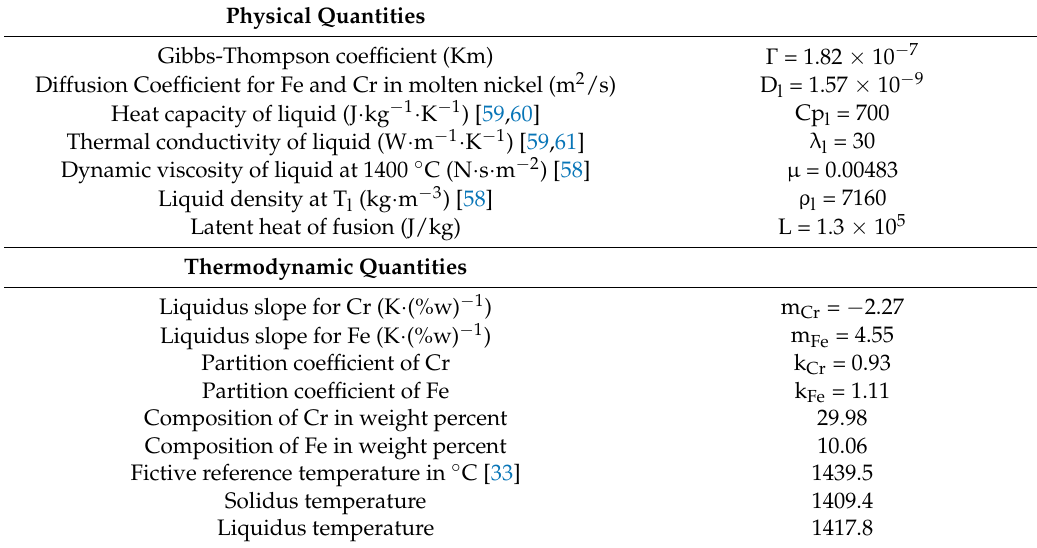
Table 5. Physical and thermodynamic data used for the calculations.